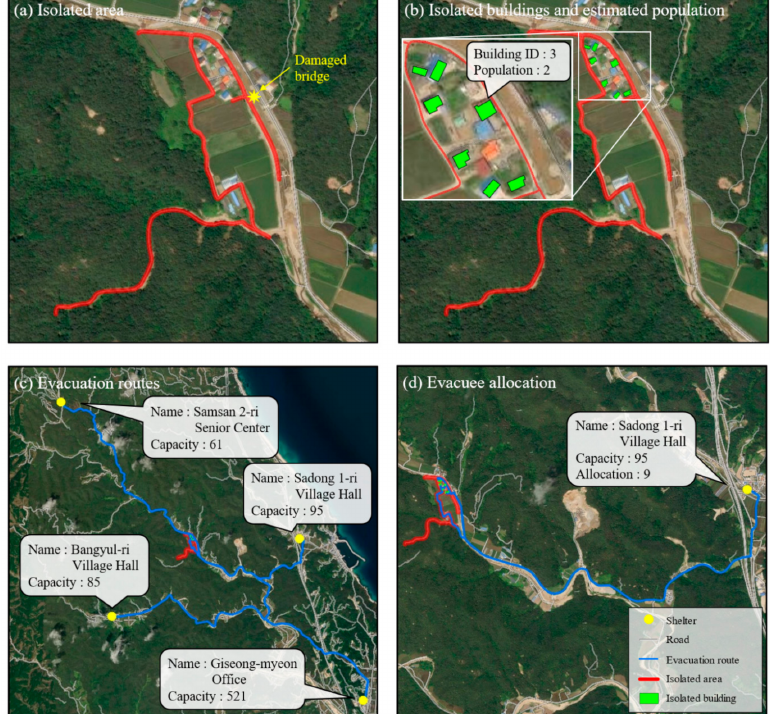
Figure 7. Mapping results for an area where a disaster has occurred in the past: Samsan 1 ri, Uljin-gun in Gyeongsangbuk-do: ( a ) Isolated area; ( b ) buildings and population in the isolated area; ( c ) possible evacuation routes; ( d ) the nearest shelter for